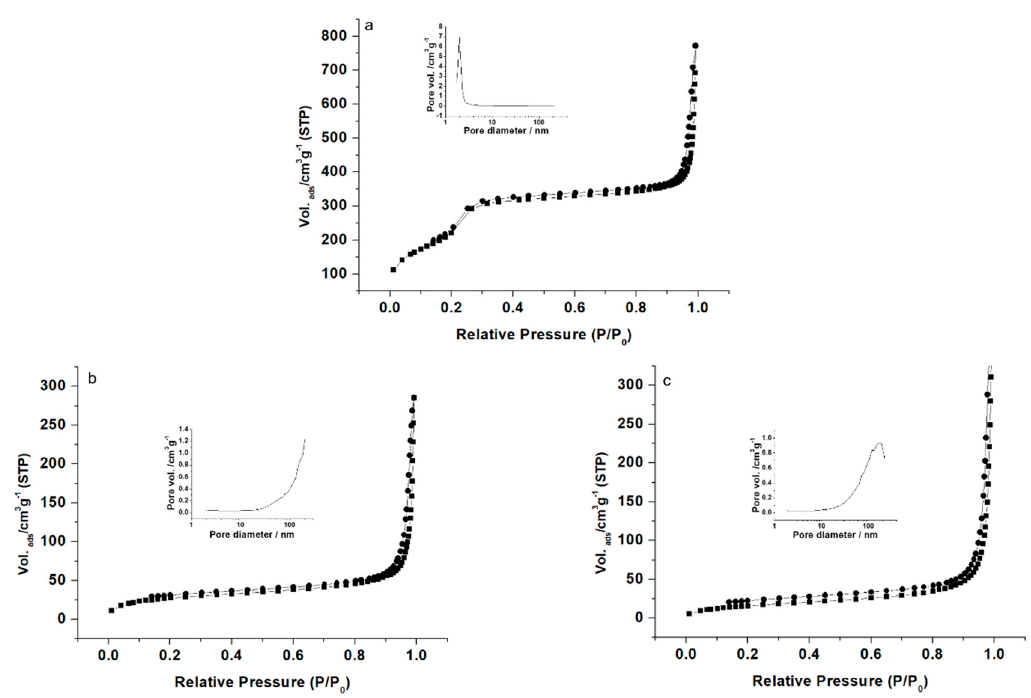
Figure 3. Nitrogen adsorption–desorption isotherms for ( a ) MSN, ( b ) MSN-Eu and ( c ) Maltodextrin-MSN-Eu. The insets in each graph show the pore size distributions of the systems. Table 2. BET-specific surface values, pore volumes and pore sizes calculated from the N 2 adsorption–desorption isotherms for selected materials.